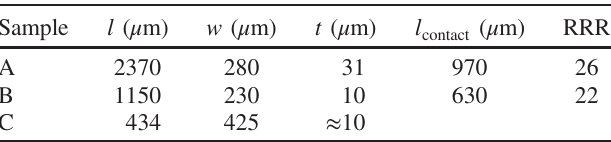
TABLE II. Sample parameters: length, width, thickness, sep- of the voltage contacts, and the residual resistivity aration l contact ratio (RRR) ρ ð 300 K Þ = ρ ð 12 K Þ . Note that at 12 K there is still strong inelastic scattering.